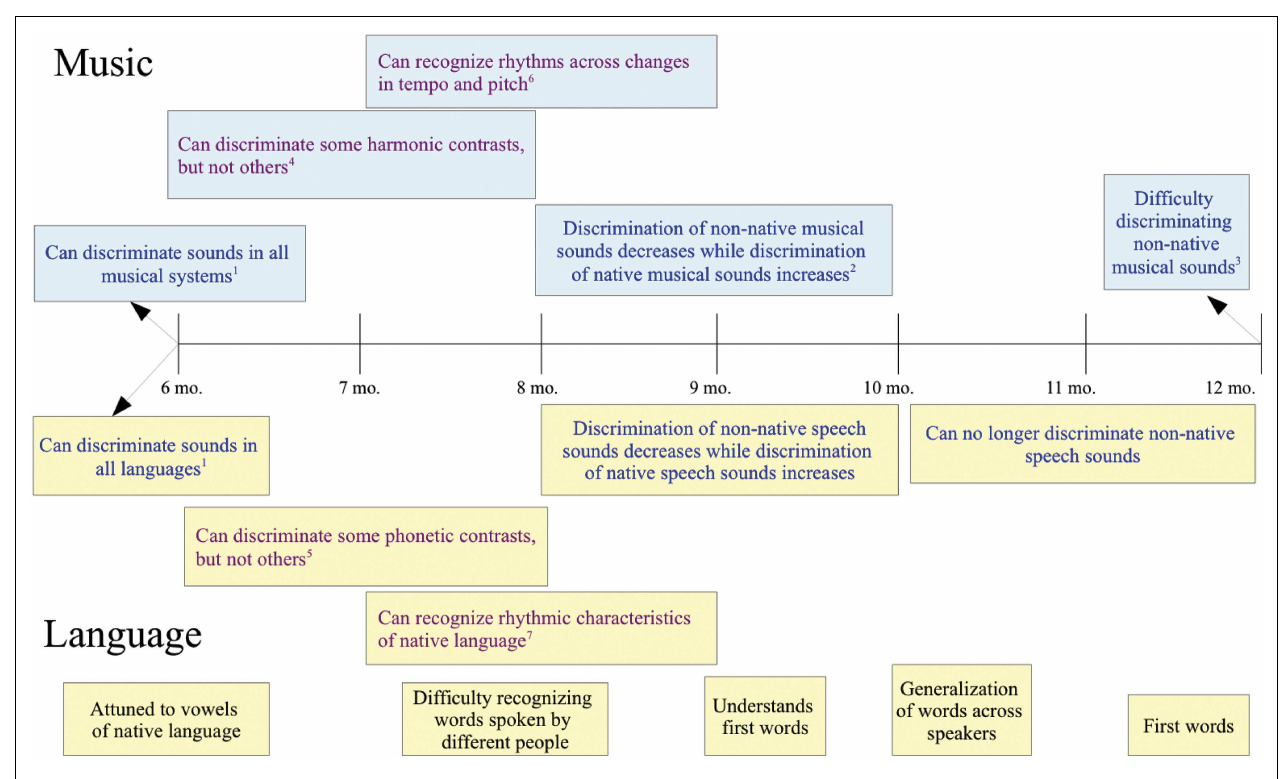
scales than in Javanese scales and have more difficulty detecting changes in complex than simple meters. (4) Between 6 and 8months, infants can discriminate consonant from dissonant intervals, but have difficulty discriminating between different consonant intervals (Schellenberg and Trainor, 1996). (5) Between 6 and 8months, can no longer discriminate non-native vowel contrasts, but can still discriminate non-native consonant contrasts. (6)Trehub andThorpe (1989). (7) At 7.5–8months, English speaking infants show a bias for stress-initial words and are sensitive to prosodic and frequency cues to word